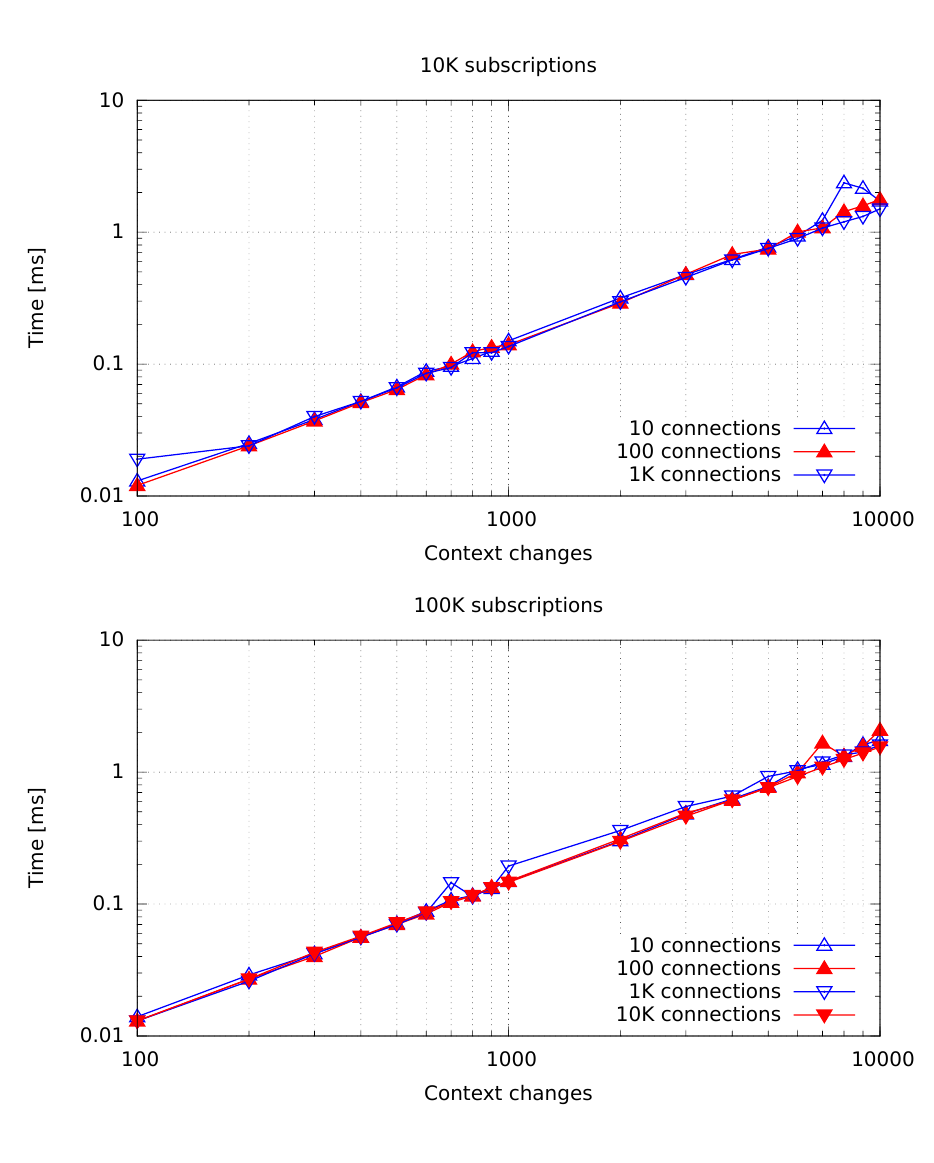
Figure 8. Time taken to change context with 10,000 and 100,000 subscriptions on a single broker in our